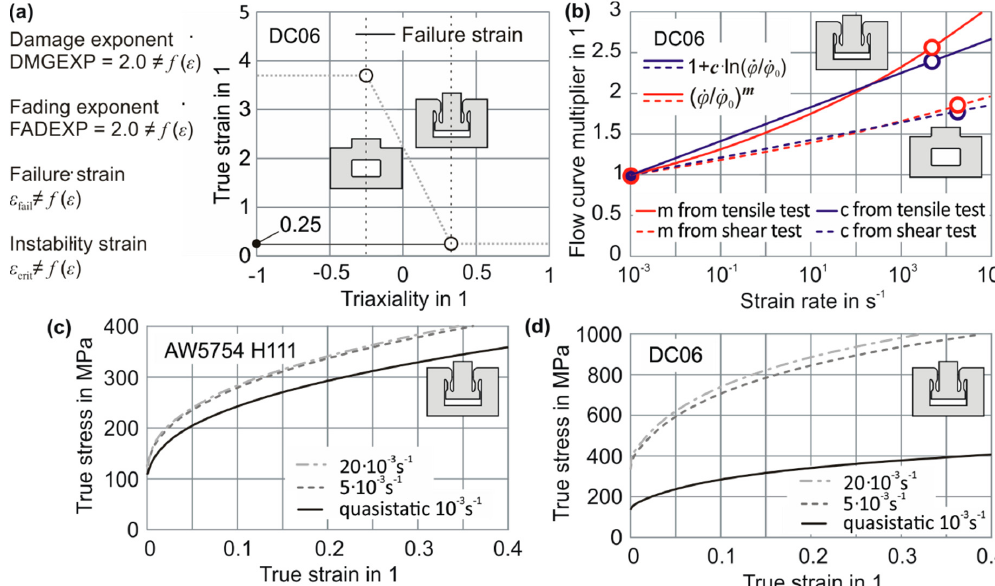
Figure 19. ( a ) Identified GISSMO parameters for DC06. ( b ) Identified strain rate sensitivity of